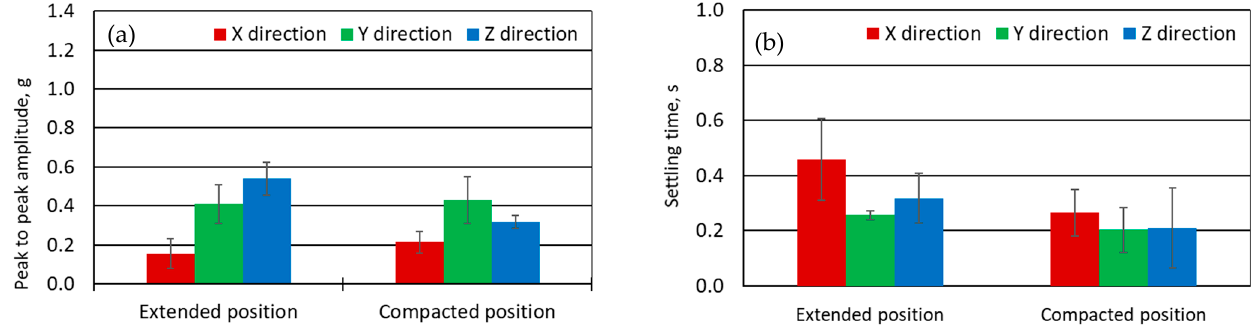
Figure 14. Influence of the robot positions (extended position and compact position) in to ( a ) peak-to-peak vibrations amplitudes; ( b ) settling times. Statistical evaluation was performed by Equations (8)–(13).